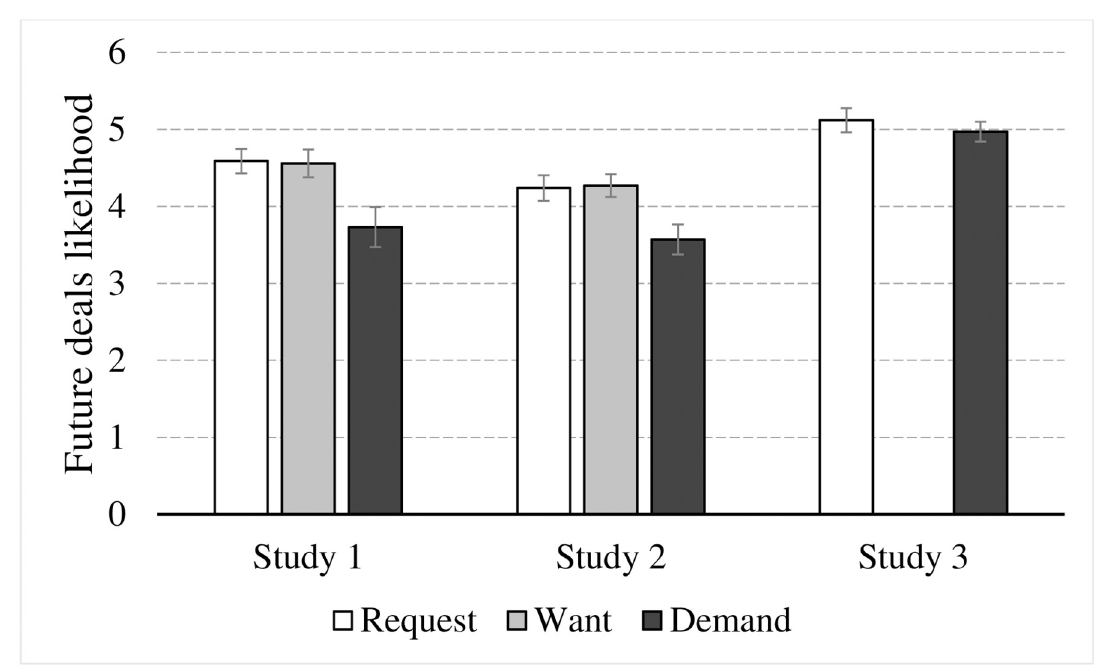
Fig 3. Averaged likelihood of conducting future deals as a function of the language used to request a discount in all three experiments. Vertical lines depict standard error.